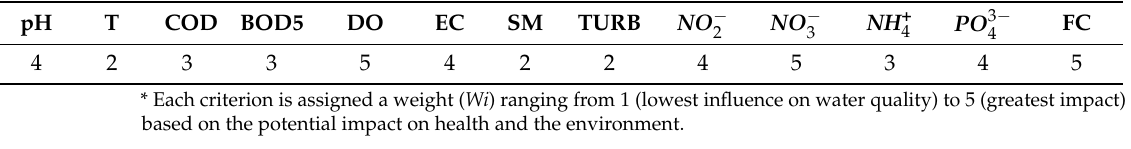
Table 4. Weights assigned to parameters [32].